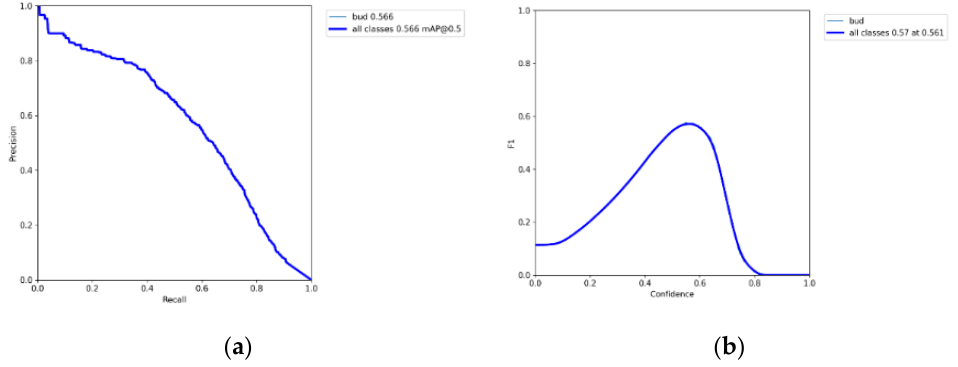
Figure A1. The changes of recall of YOLOV5n.